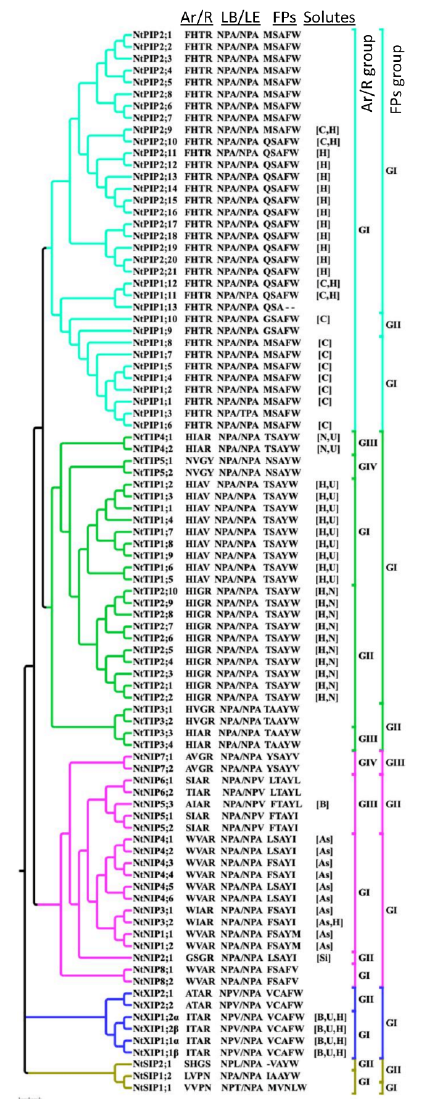
Figure 3. Grouping of N. tabacum PIPs, TIPs, NIPs, SIPs, and XIPs based on the ar/R and FPs.